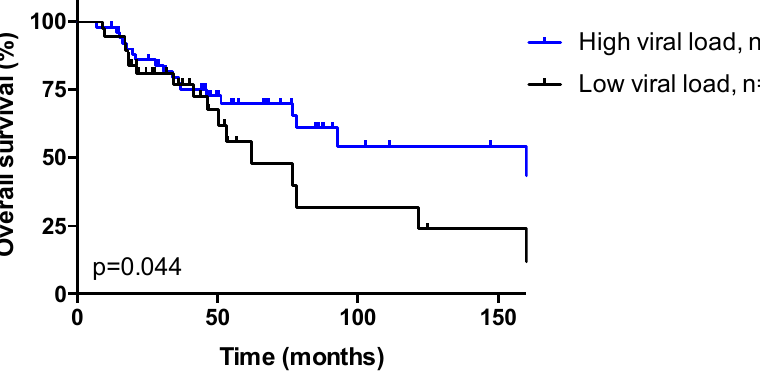
Figure 3. Overall survival (OS) curves of the 90 patients with HPV-positive anal squamous cell carcinoma (ASCC) evaluable for survival, according to HPV viral load. Median OS: 62.2 months in low ( < 12) viral load vs. 168.2 months in high ( ≥ 12) viral load. Log-Rank test, hazard ratio (HR): 1.89, p = 0.044.